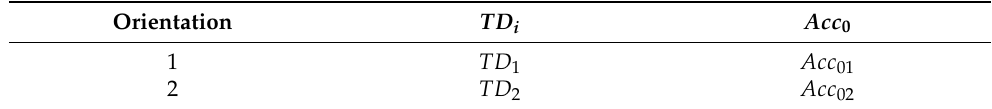
Table 2. Final data obtained for each